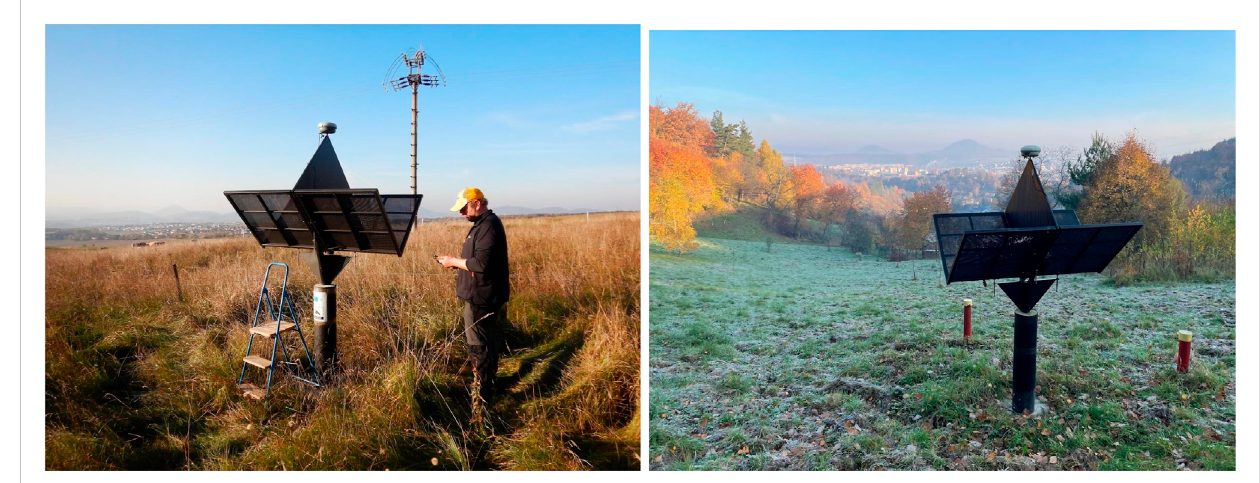
FIGURE 10 Example of CR installation and stabilization in a landslide zone.